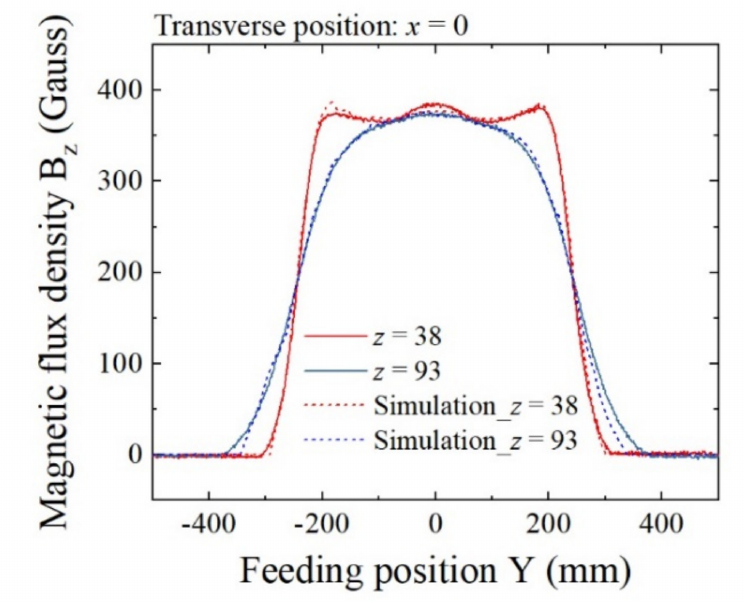
Figure 11. Comparison of measurement and simulation of B z at different heights Z. (Unit of z :